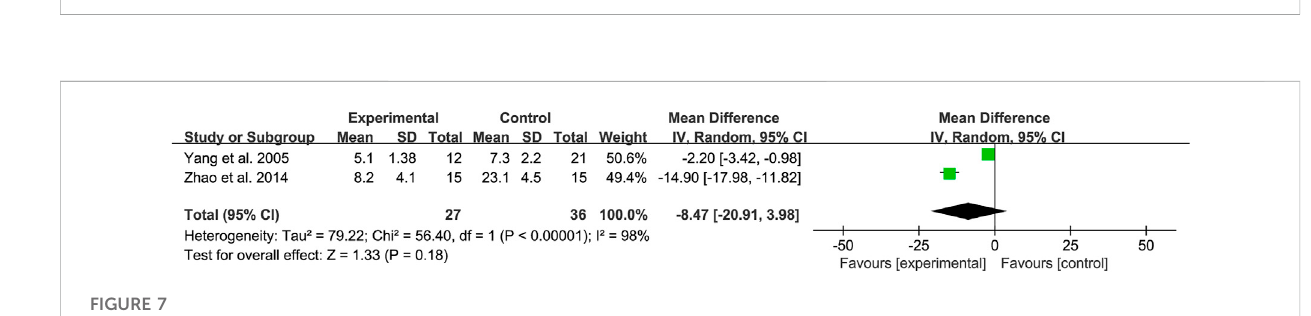
FIGURE 7 Forest map of number of metastatic